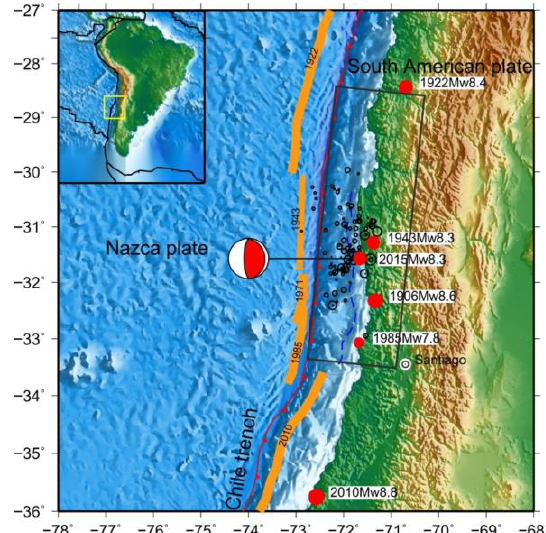
Figure 1. Tectonic setting of 2015 Chile Mw8.3 event. Black circles of different sizes are aftershocks (http://earthquake.usgs.gov, as of 18/9/2015). The red barbed line is the trench. Color stripes along the trench depict